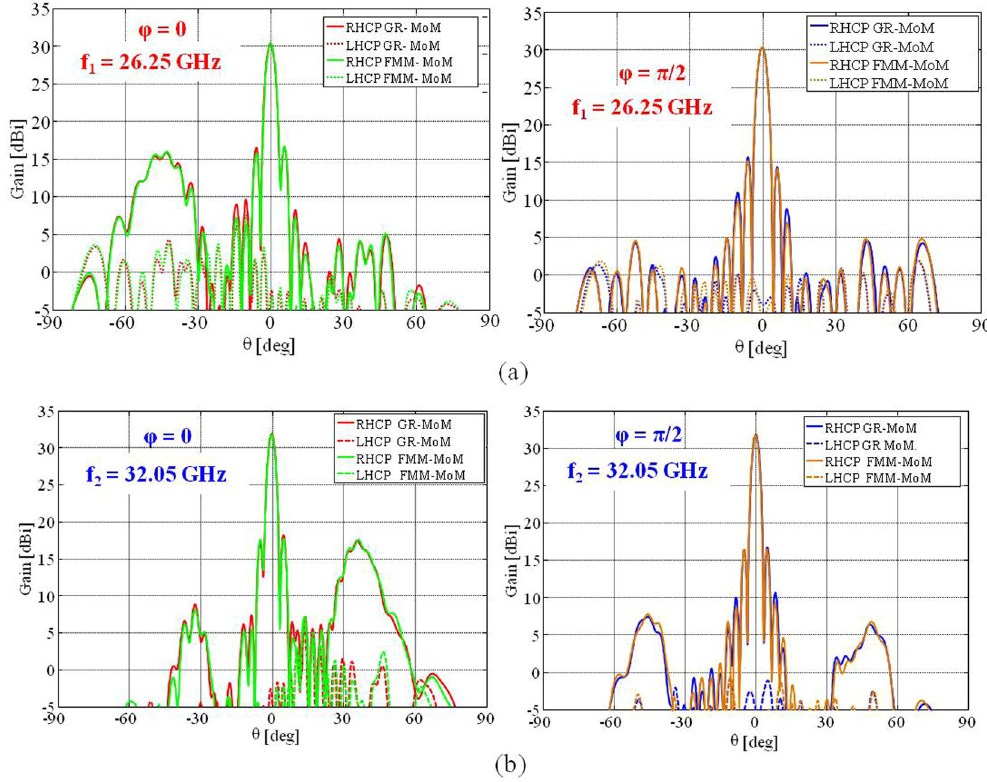
Figure 11. Comparison between the directivity patterns obtained with the GR-basis MoM and the FMM approach that exploits entire domain basis functions for elliptical elements at ( a ) f = 26.25 GHz and ( b ) f = 32.05 GHz. The solid and dashed red and blue lines show the co-polar and cross-polar components, respectively, of the pattern evaluated by the impedance BC-MoM. The solid and dashed green and orange curves present the co-polar and cross-polar components of the radiation pattern, respectively, obtained by the FMM